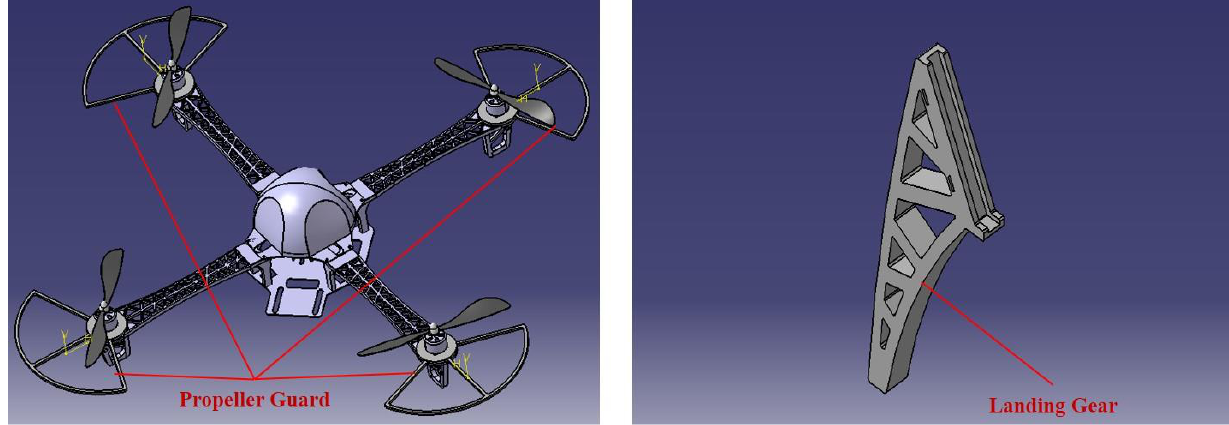
Figure 2. CATIA modeling for the drone along with the propeller guard ( left ) and the landing gear ( right ).